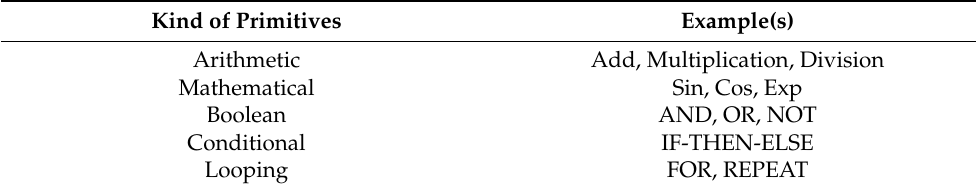
Table 1. Function